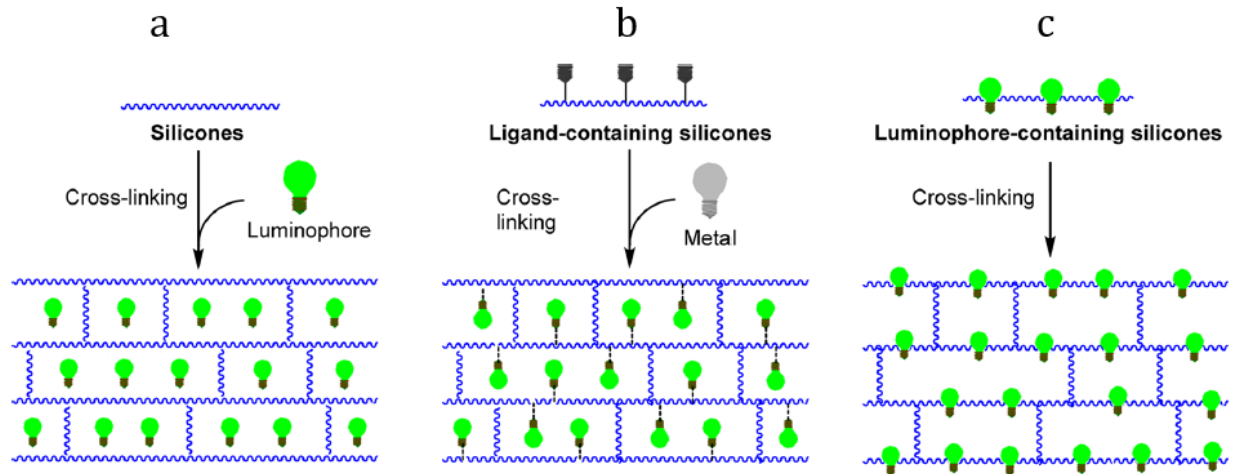
Figure 6. General approaches to luminescent silicone rubbers: use of fillers ( a ), metal binding ( b ), and copolymers ( c ). Reproduced with permission [88]. Copyright 2021, American Chemical Society.